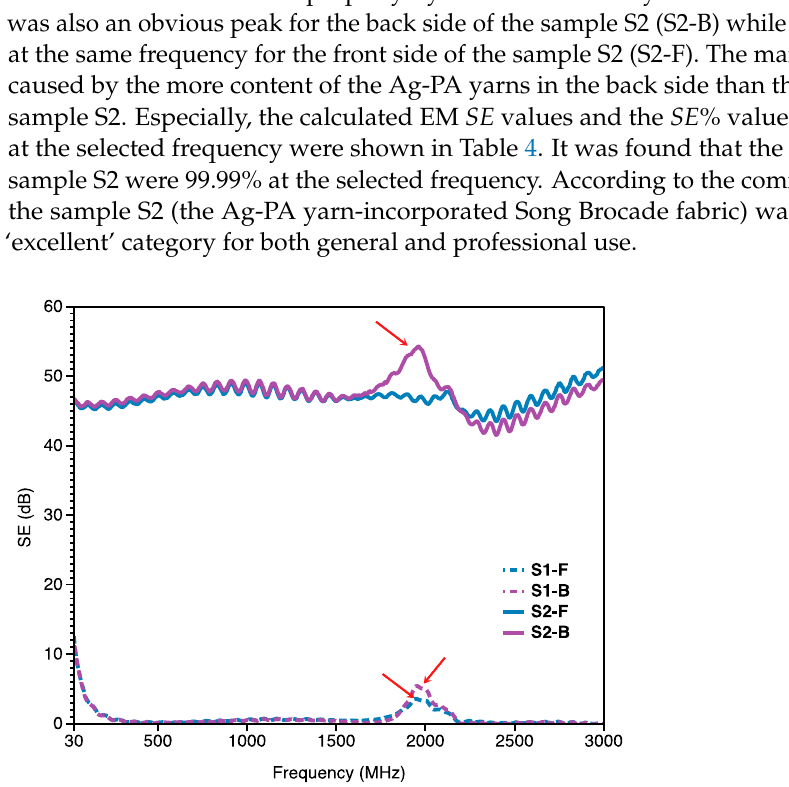
Figure 6. SEM-EDX results for both sides of two Song Brocade fabrics (( A , A’ ): the front side and back side of sample S1; ( B , B’ ): the front side and back side of sample S2).